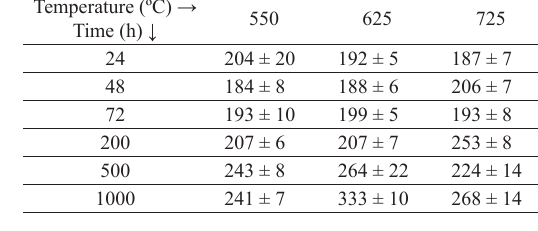
Table 2. Vickers microhardness of Inconel 625 superalloy as function of aging time and temperature.